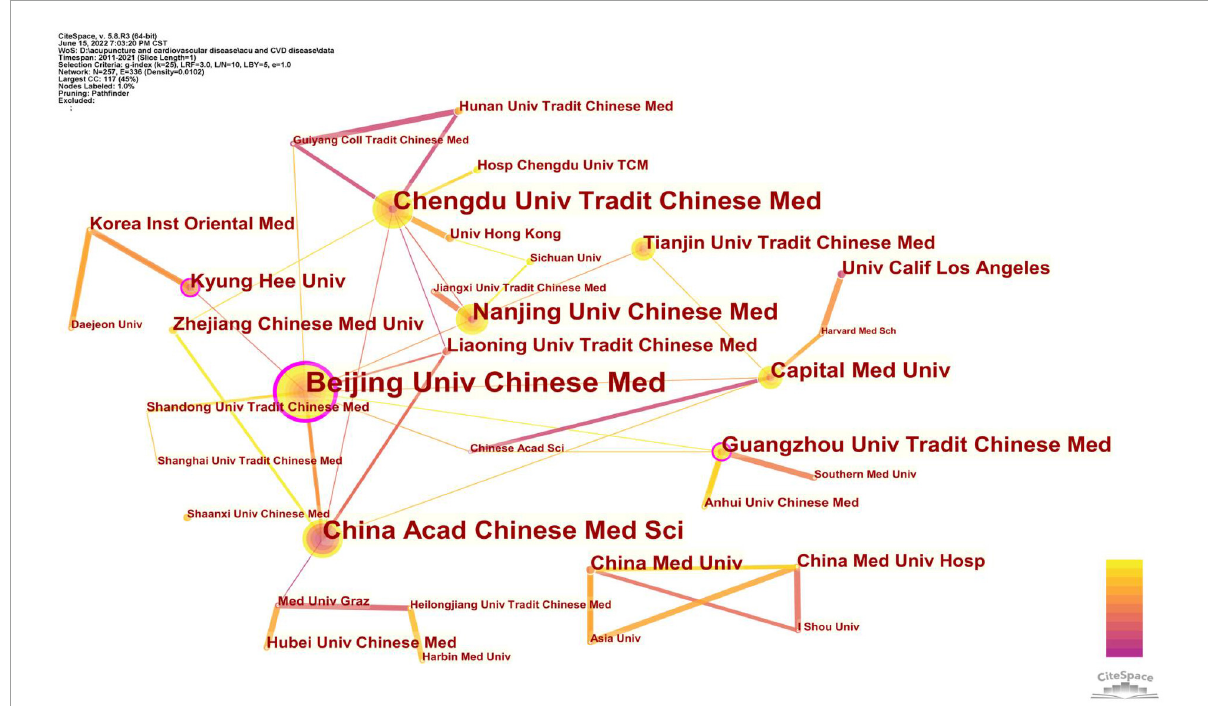
FIGURE3 Network map of co-authorship between institutions about acupuncture on